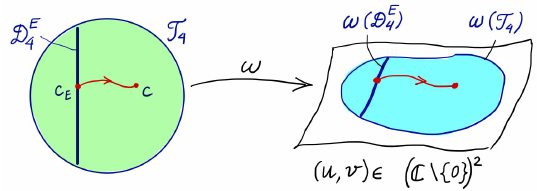
Figure 2 . Illustration of the discussion in section